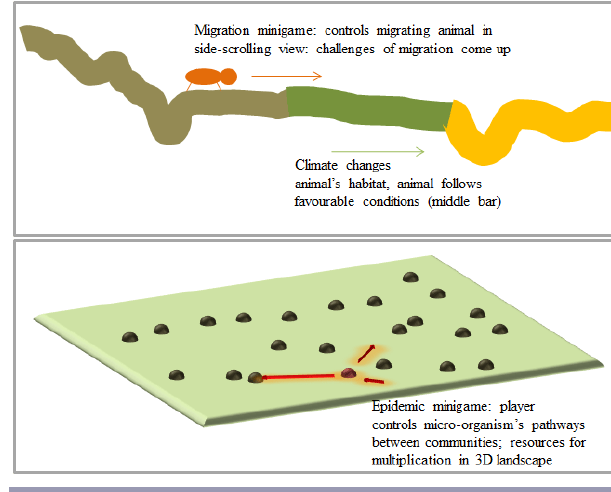
Fig. 3 . Two simplified examples of microgames in Levels of Life representing bonus cross-level interactions. In one, the player takes the perspective of a single animal that has to migrate along with its favorable conditions across a continent, in a side-scrolling minigame. In another, the player plays a micro-organism that attempts to spread across a number of host communities, in a simple 3D strategy game.